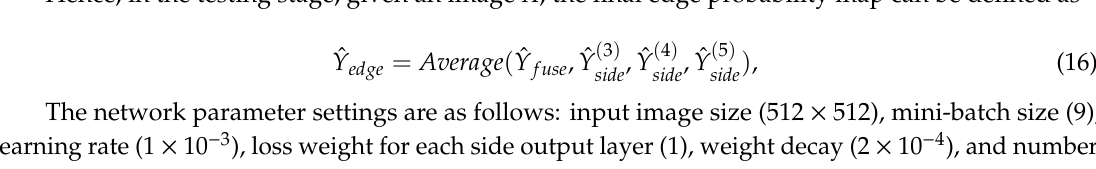
Figure 10. Two example images and ground-truth edge results for our dataset: ( a , c ) Input images; ( b , d ) ground-truth edges by human annotation of ( a , c ), respectively.